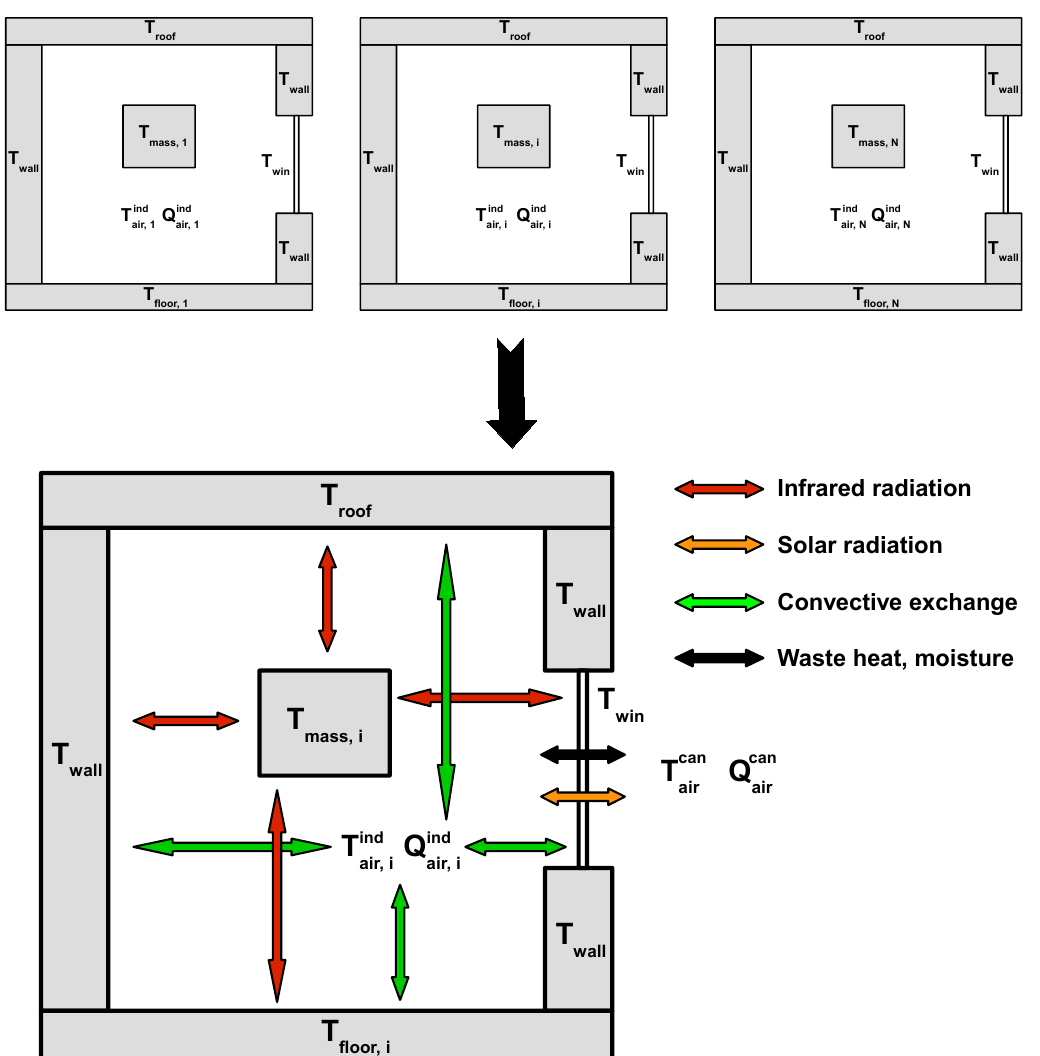
Figure 2. Overview of our methodology for parametrising fractional building use and human behaviour at grid point scale. For the N different uses/behaviours we solve the equations for the indoor air and humidity, the internal mass and the ground floor N times. The equations for the building envelope and the outside of the building are solved only once. The fluxes due to convection, shortwave and long-wave radiation and air exchange towards the roof, wall, window and the outside are aggregated over the N fractional uses/behaviours. No direct exchanges between the different uses and behaviours are taken into account since we do not seek to represent exchanges between different compartments in one